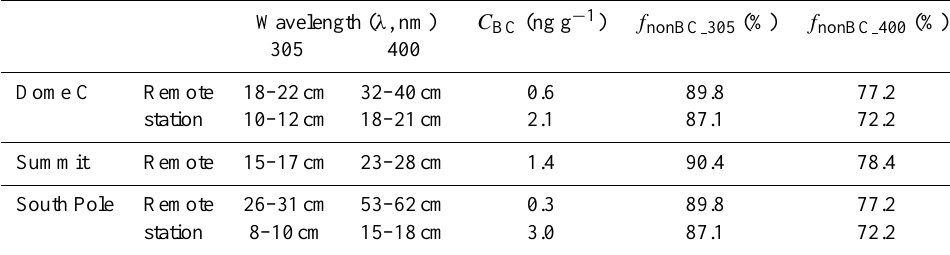
Table 5. Calculated e-folding depths of actinic flux ( z e ) in snow near the station and remote from the station in the designated clean-air sector for January at Dome C and South Pole and June at Summit for λ = 305nm and λ = 400nm. The range of e-folding depths represents the range between fully direct (smaller z e ) and fully diffuse (larger z e ) incident radiation conditions. Values of C BC , f nonBC 305 , and f nonBC 400 used to calculate z e at each location are